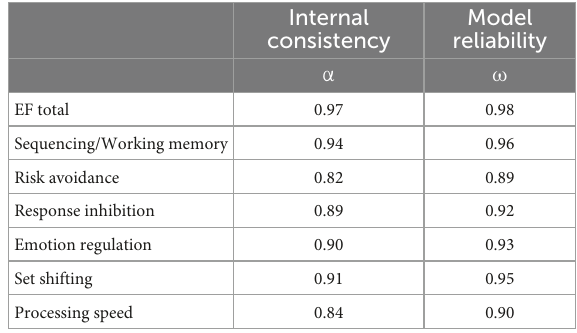
TABLE 3 Reliability statistics for Executive Functioning Scale (EFS) general (total scores) and specific factors (subscale